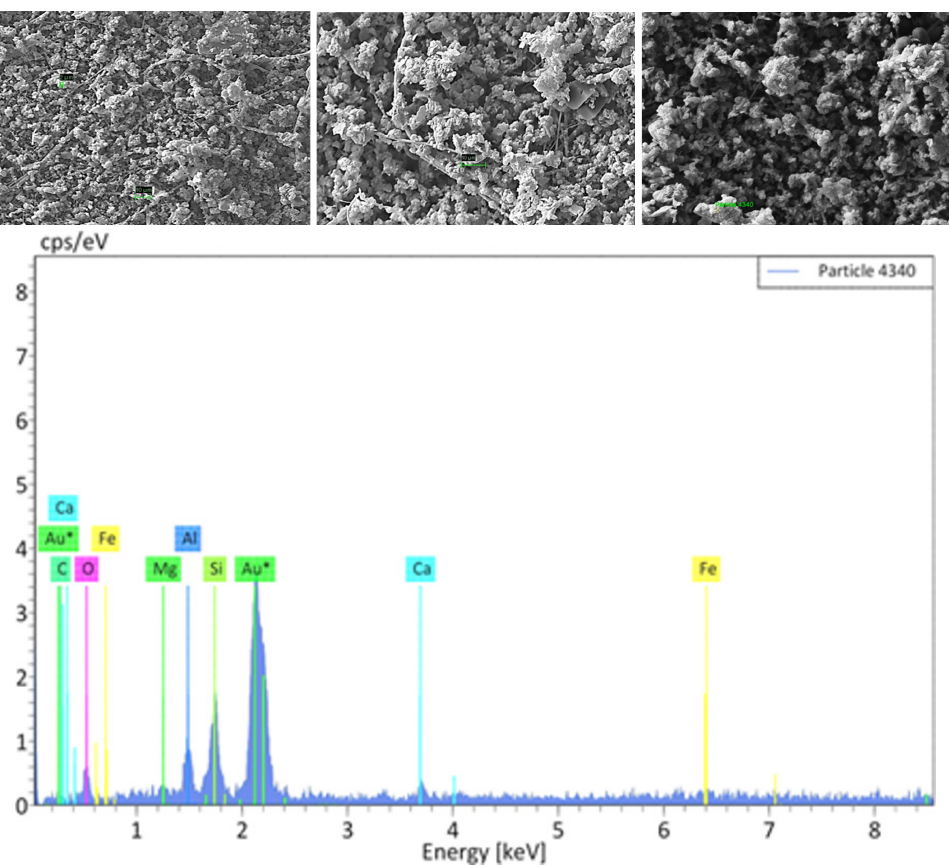
Figure 7. 25 April 2019 dust event, magnified sampled filter image and elements concentration.